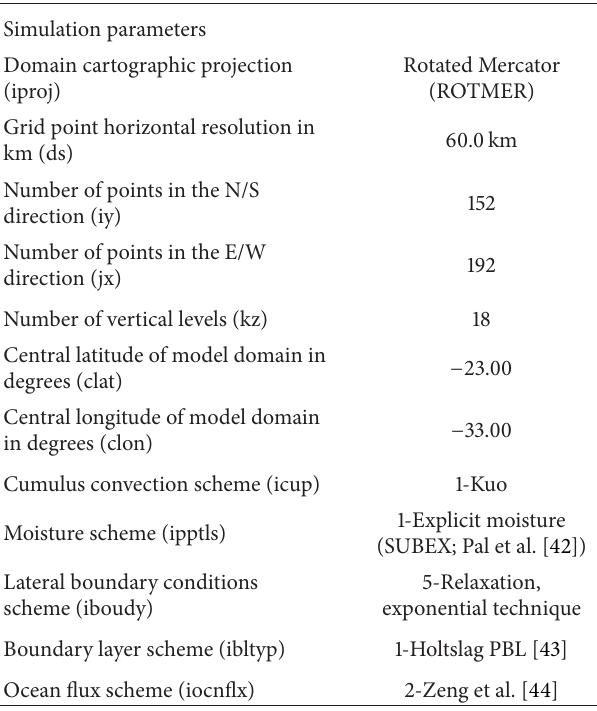
Table 1: Technical details of the simulation